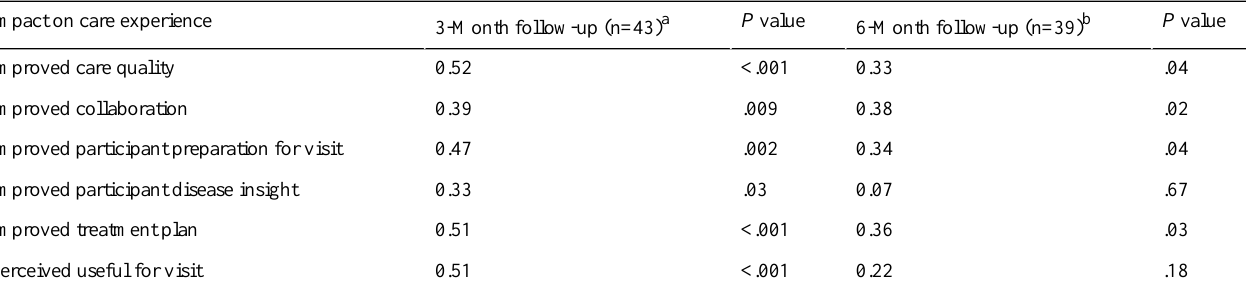
Table 3. Pearson correlation coefficients between patient-reported outcome completion rate and impact of Orchestra on care